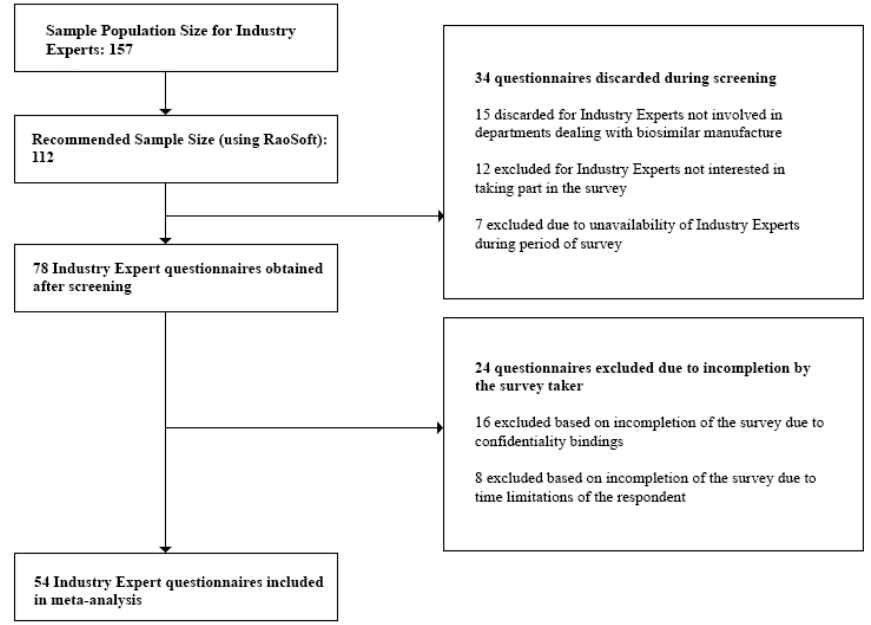
Figure 2. Questionnaire screening process for Industry Experts.